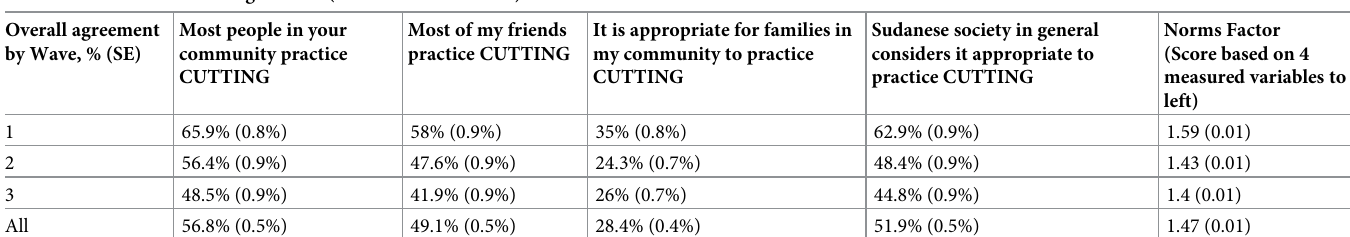
Table 1. FGM social norms agreement (lower scores desirable).